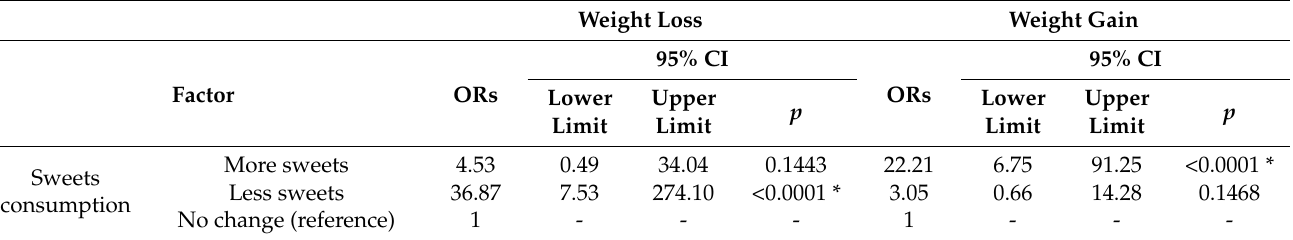
Table 4. Odds ratio for type of change in body mass (weight gain, weight loss or unchanged) during the COVID-19 pandemic by sweet consumption